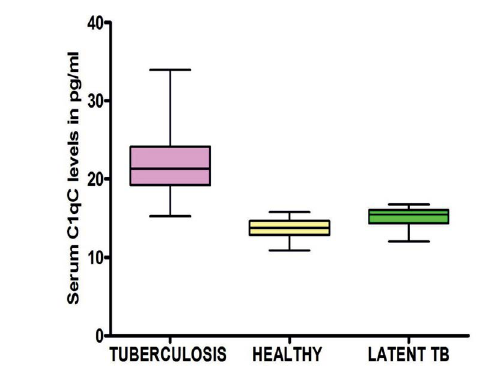
Fig. 4. Complement C1q subcomponent subunit C (C1qC) levels in different study